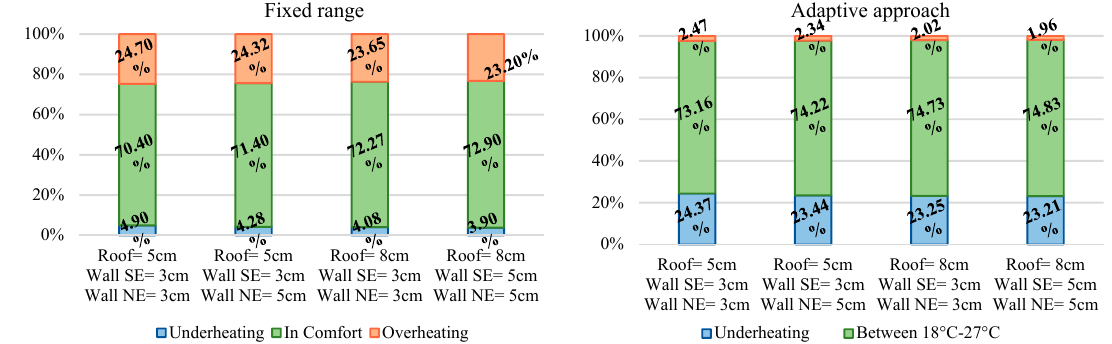
◦ . Figure 16. Simulations results of the building rotated 180°.